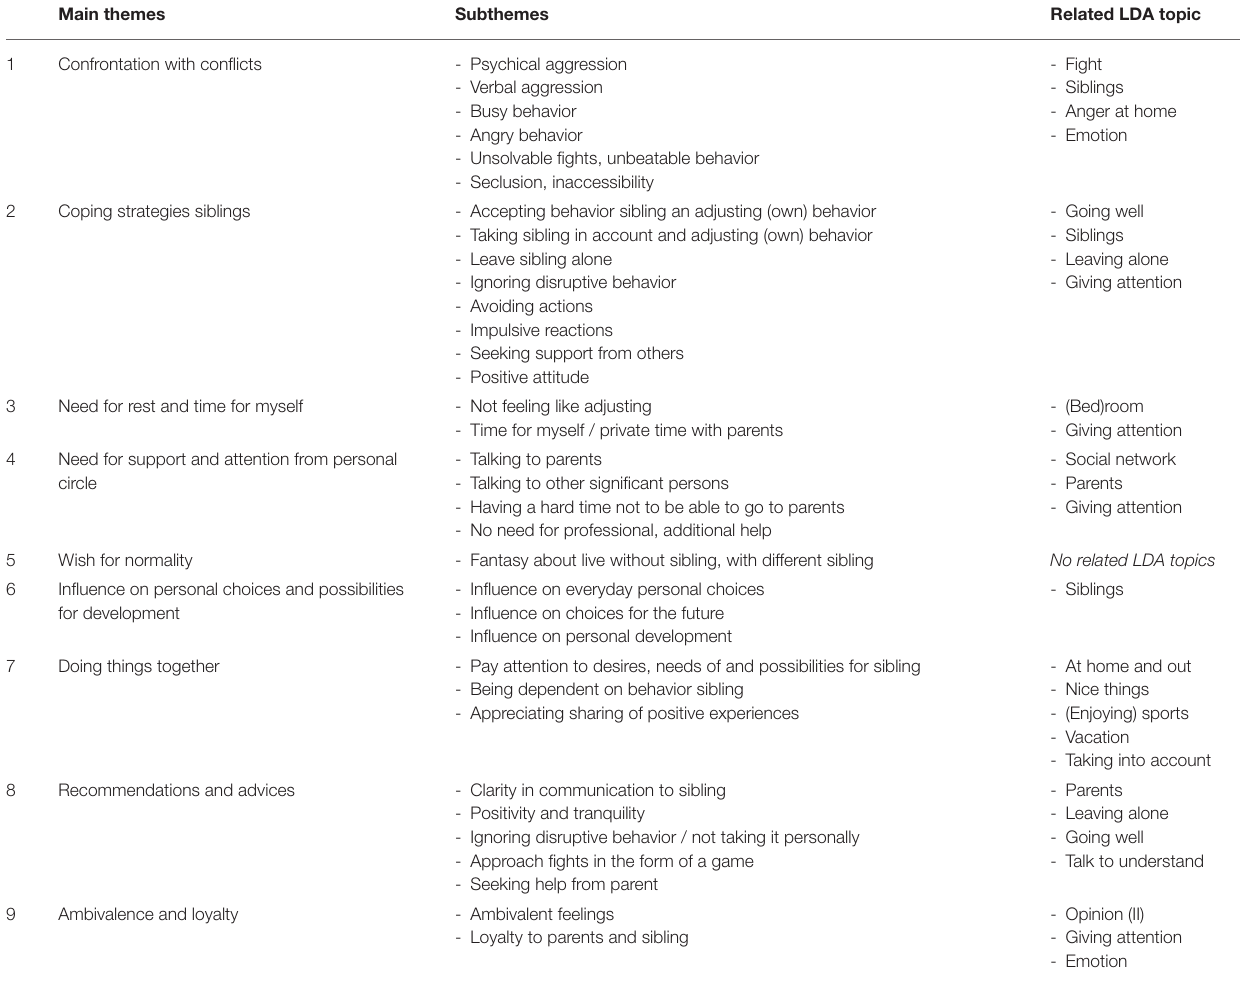
TABLE 3 | Main and subthemes found with manual qualitative analysis, alongside corresponding LDA